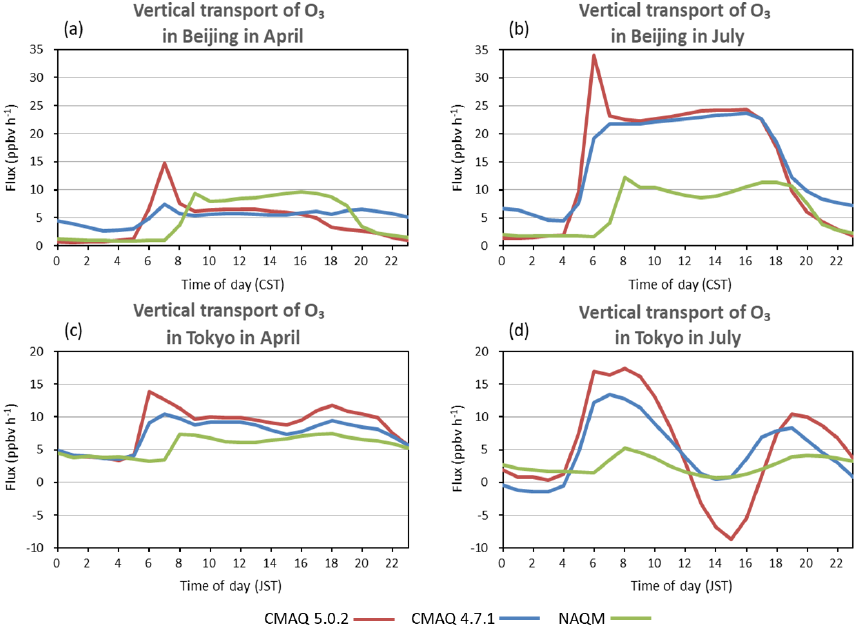
Figure 6. Comparison of vertical transport of O 3 in (a) Beijing in April, (b) Beijing in July, (c) Tokyo in April, and (d) Tokyo in July.